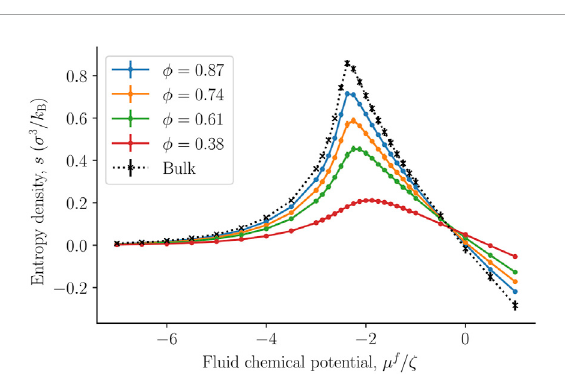
FIGURE 11 Theentropydensity s = S / V asafunctionofthe fl uidchemical potential μ f for varying porosities ϕ = V f / V . The integral pressure is assumed to be equal to the bulk